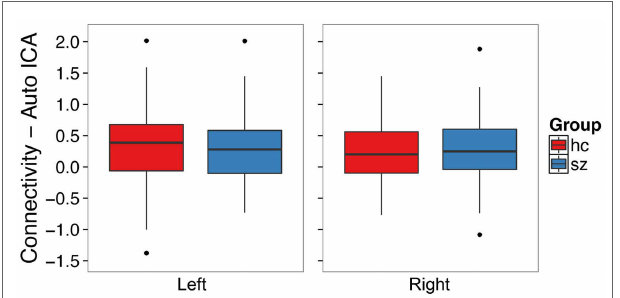
Figure 4 | Functional connectivity with the default mode network from single subject level ica with automatic component estimation does not differ between schizophrenia patients and healthy controls in the left or right hippocampus . The boxplots show the median, interquartile range, and outliers. The whiskers extend to the lowest value within 1.5 times the